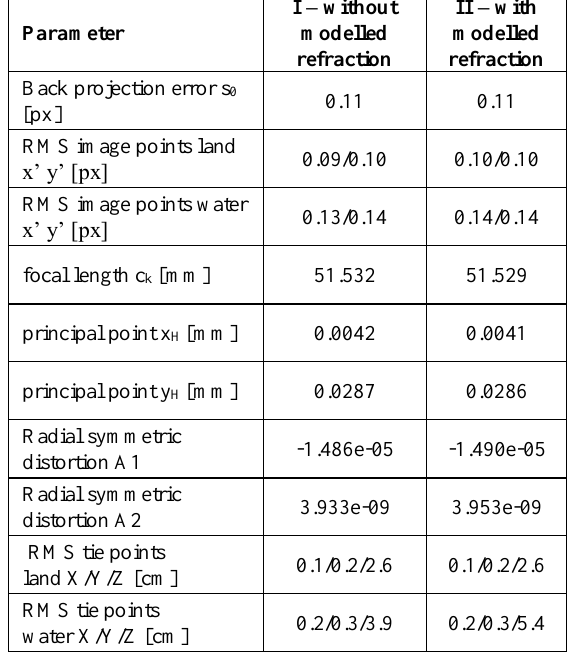
Table 1. Bundle adjustment results with and without